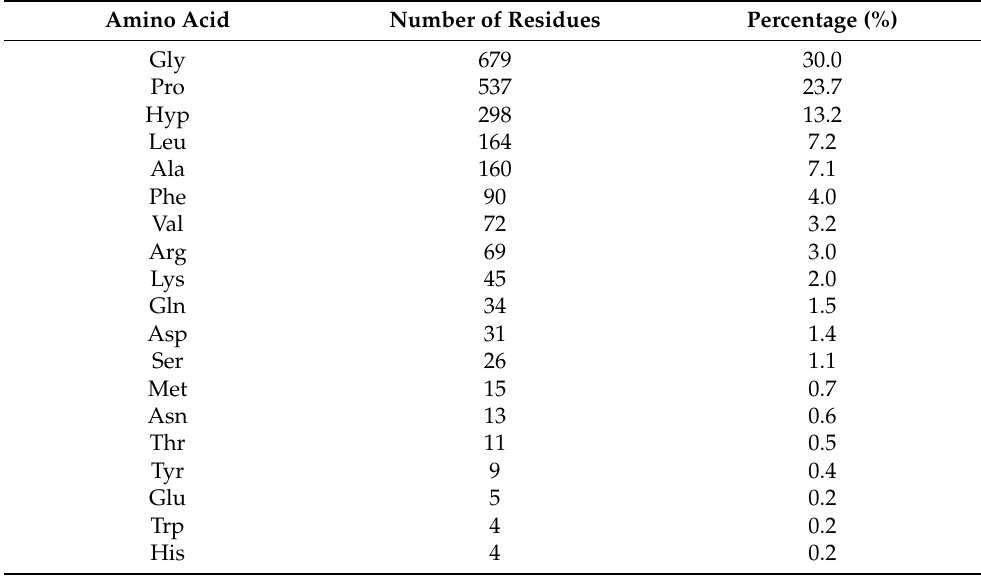
Table 2. Amino acid composition of